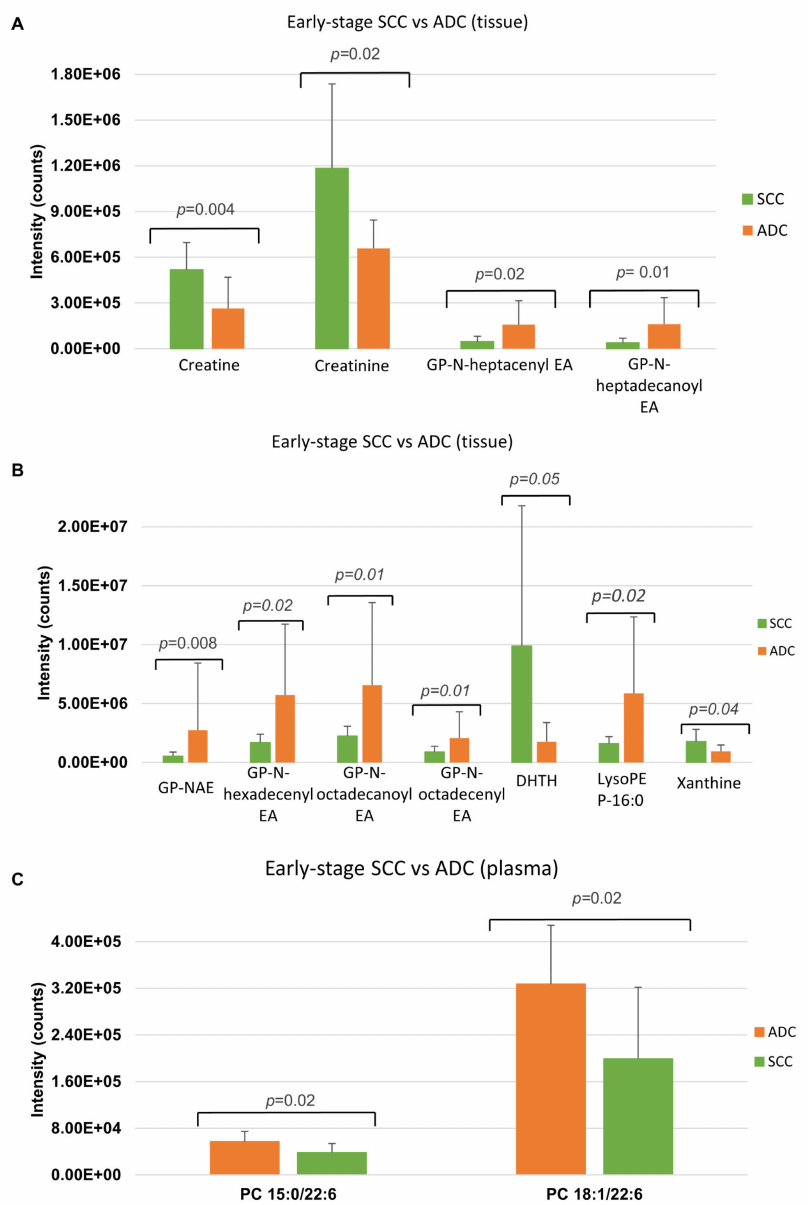
Figure 2. Metabolites that differentiate the early stages of SCC from ADC in tissue and plasma samples. Panels ( A , B ) show the intensity of selected identified tissue metabolites that differentiate the early SCC and ADC subtypes. Panel ( C ) shows the intensity of selected identified plasma metabolites that differentiate the SCC and ADCS subtypes (* p -value < 0.05; ** p -value < 0.01). Glycerophospho- N-heptacenyl ethanolamine (GP-N-heptacenyl EA); glycerophospho-N-heptadecanoyl ethanolamine (GP-N-heptadecanoyl EA); glycerophospho-(N-acyl)-ethanolamine (GP-NAE); glycerophospho-N- hexadecenyl ethanolamine (GP-N-hexadecenyl EA); glycerophospho-N-octadecanoyl ethanolamine (GP-N-octadecanoyl EA); and glycerophospho-N-octadecenyl ethanolamine (GP-N-octadecenyl EA), dihydrothymine